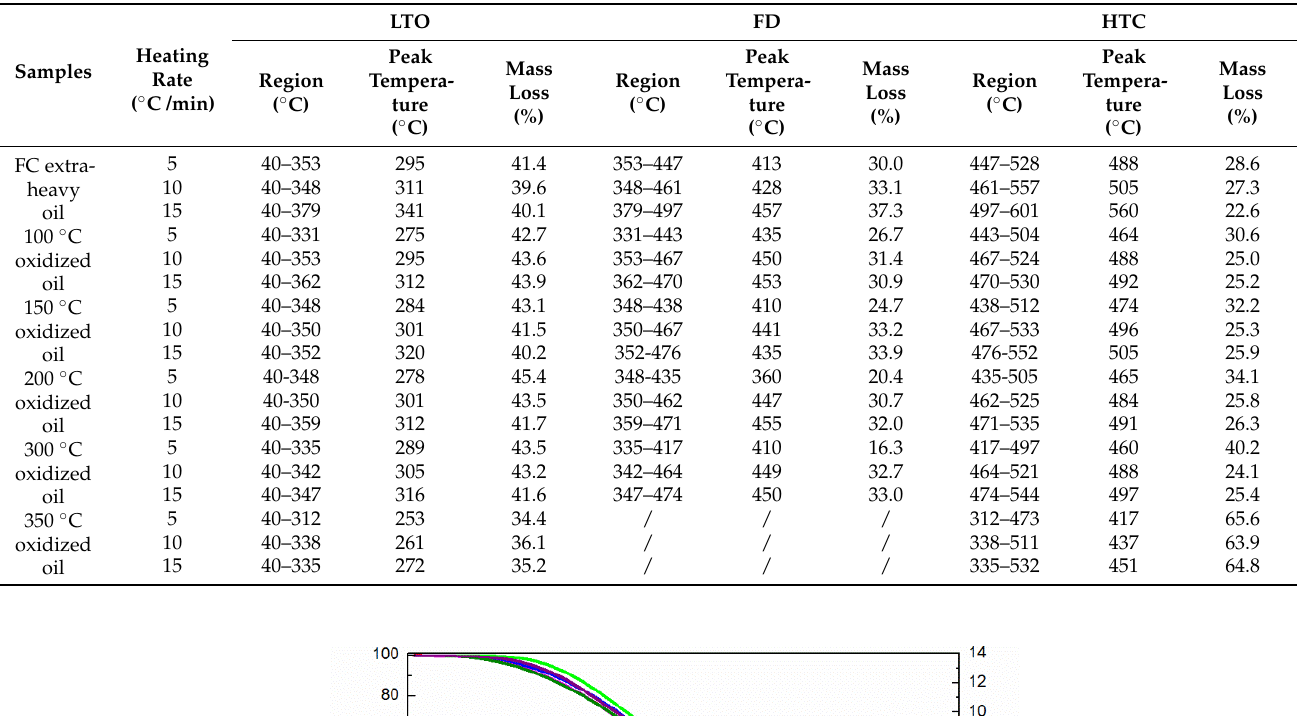
Table 4. TG/DTG curve parameters of the FC extra-heavy oil and oxidized oils.